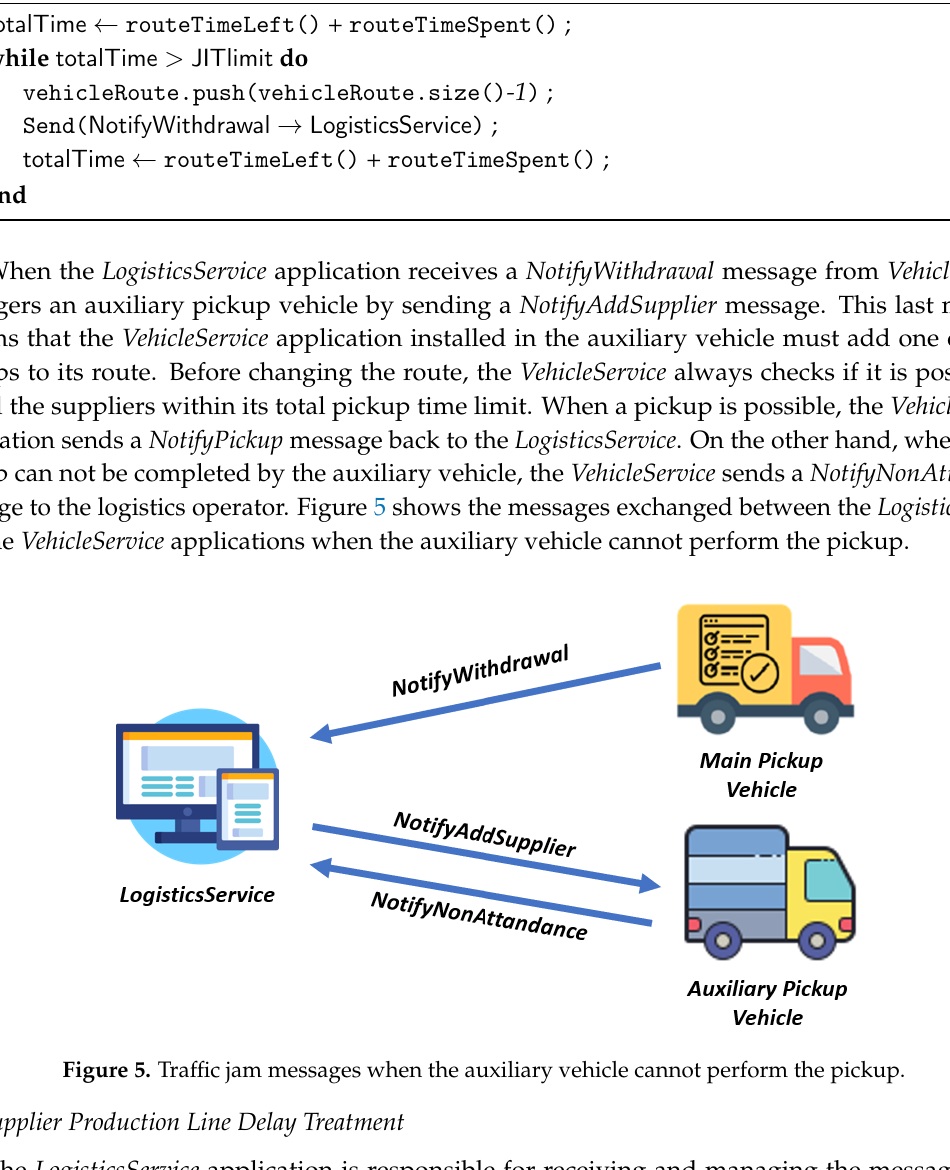
Algorithm 1: Delay management (DM) process